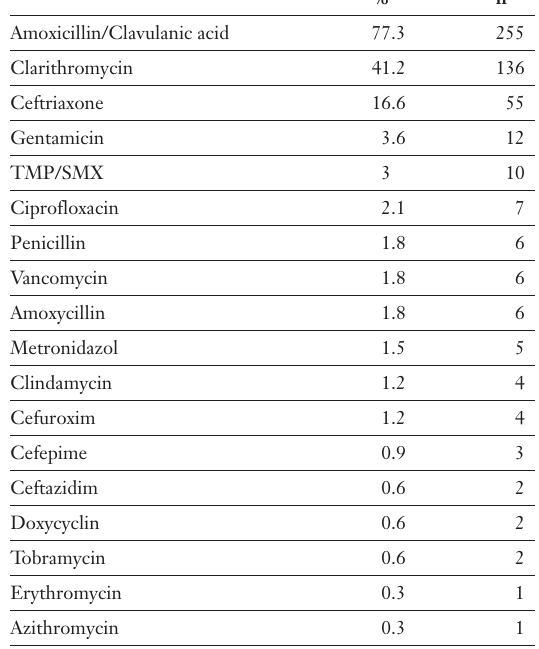
Antibiotic treatment* (n =